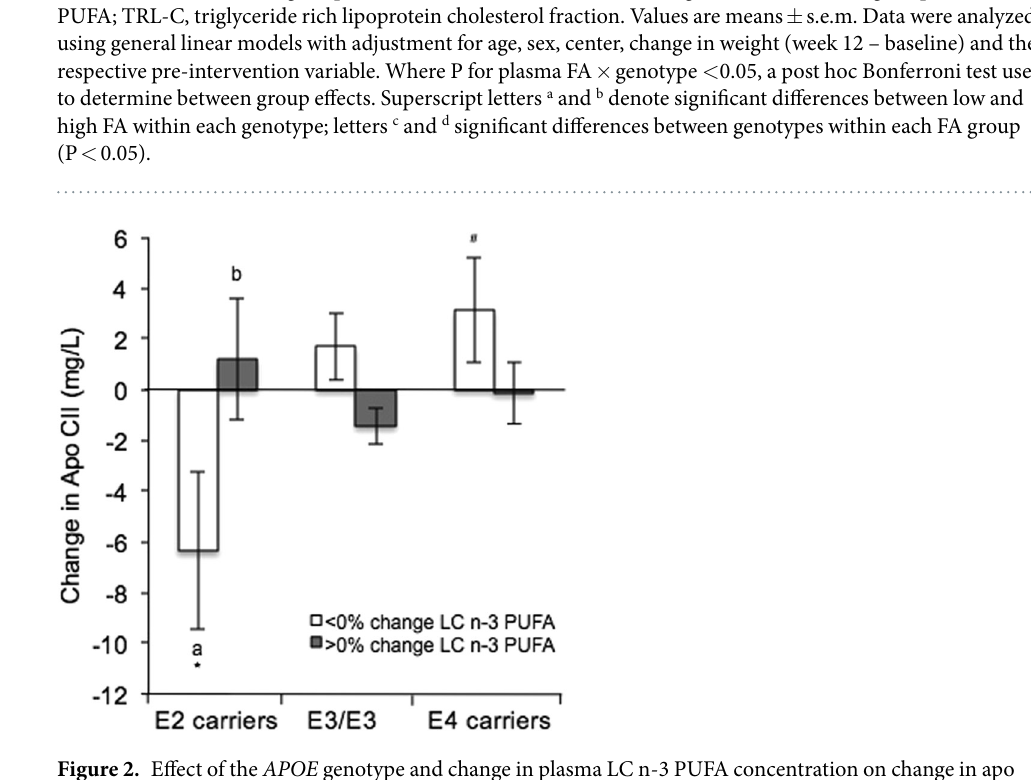
Figure 2. Effect of the APOE genotype and change in plasma LC n-3 PUFA concentration on change in apo CII ( APOE × LC n-3 PUFA interaction, P = 0.041) following the LIPGENE Dietary Fatty Acid Intervention in metabolic syndrome subjects. Values are means ± s.e.m. Letters (a and b) are used to denote